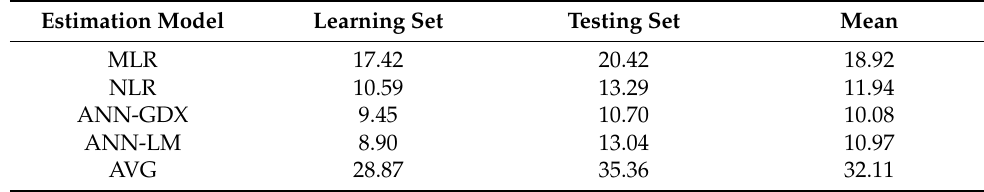
Table 4. The results of experiments (in %).